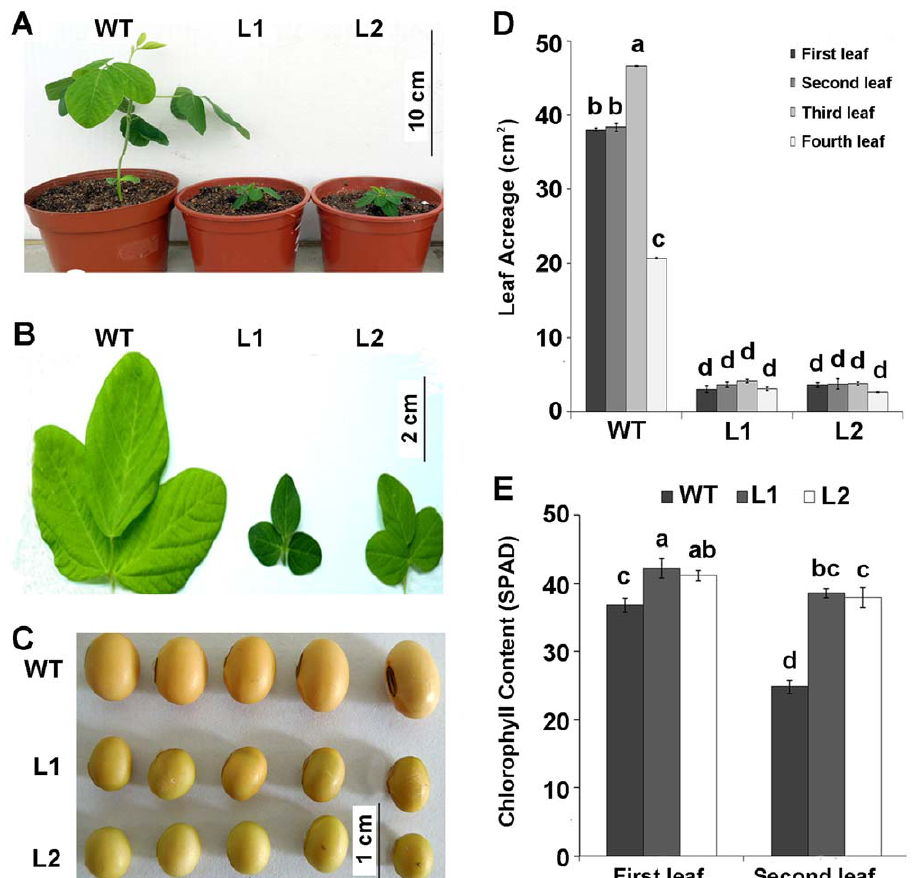
Figure 2. Phenotypes of AtDREB1A -overexpressing soybean plants. A: Phenotypes of 3-week-old T 3 transgenic and WT soybean plants. B: Leaf phenotype of 3-week-old T 3 transgenic and WT soybean plants. C: Seeds of transgenic and WT soybean plants. D: The first to fourth leaf acreage of 3-week-old transgenic and WT soybean plants. E: The chlorophyll content of first and second leaf in transgenic and WT soybean plants. WT: wide type; L1: AtDREB1A transgenic line 1; L2: AtDREB1A transgenic line 2. Values are the mean of six biological replicates 6 SE, the same letter on each column set indicates no significant difference and different letters are significantly different by the analysis of variance (ANOVA), p , 0.05.